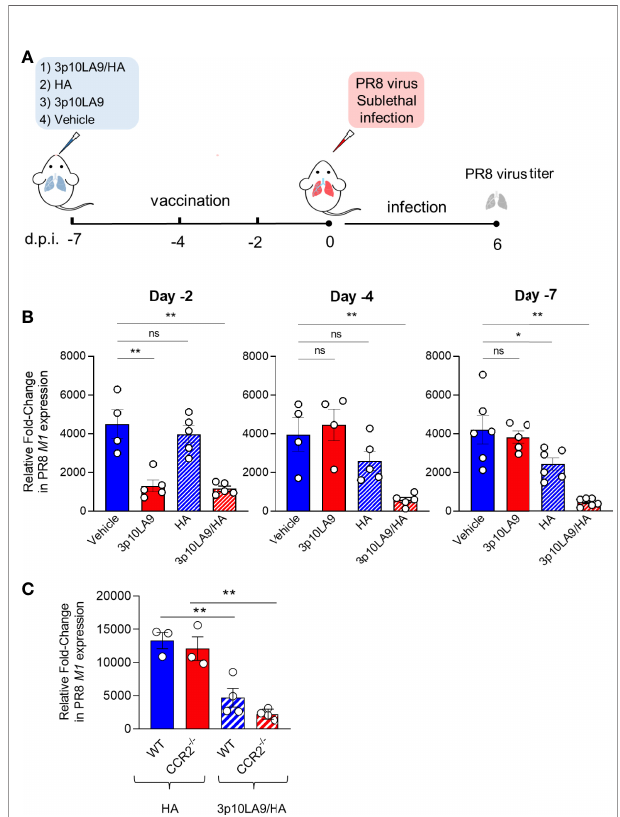
FIGURE 8 | Intranasal 3p10LA9 delivery restrains viral pulmonary load in in fl uenza-infected mice. (A) Schematic intranasal 3p10LA9 delivery and IAV sublethal infection protocol. The RIG-I agonist 3p10LA9 was intranasally administered on day 2, day 4 and day 7 before PR8 viral challenge. (B) On day 6 post-infection, lung virus load was measured by relative quanti fi cation of M1 viral protein in infected mice which have been immunized with (1) vehicle alone (2) 3p10LA9 (3) HA or (4) HA/3p10LA9 at day -2, -4 and -7, respectively. The error bars represent the SEM (n= 4-6 mice/group). * P < 0.05; ** P < 0.01; ns: not signi fi cant. One-way ANOVA with Tukey ’ s multiple comparison test. (C) Lung virus load was measured by relative quanti fi cation of M1 viral protein in infected WT and CCR2 -/- mice which have been immunized with HA mixed with 3p10LA9 (HA/3p10LA9) or HA alone on day 6 post-infection. The error bars represent the SEM (n= 3-4 mice/group). ** P <0.01; One-way ANOVA with Tukey ’ s multiple comparison